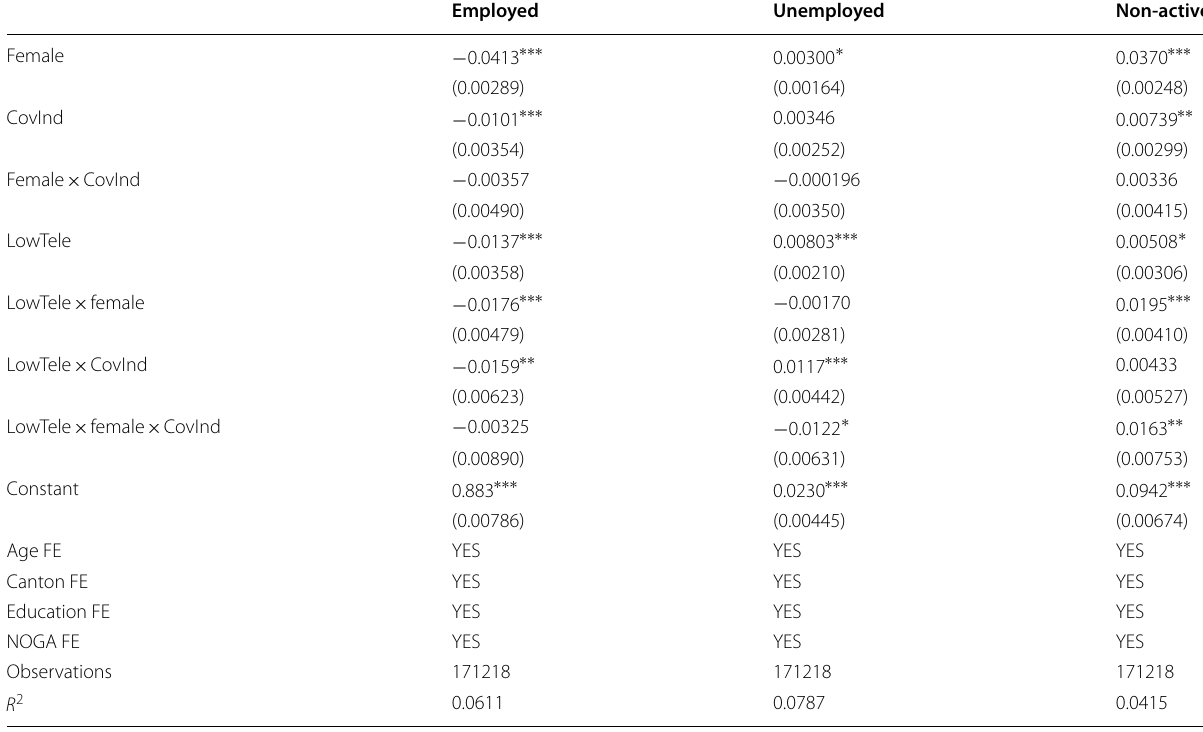
We show estimates from regression (2) of labor market status on a constant, female dummy (1 for women and 0 otherwise), COVID-19 stringency index, LowTele dummy (1 for respondents in an occupation with low telework availability and 0 otherwise), and their interactions. Regressions estimated with linear probability model, including random effects. Robust standard errors in parentheses. The sample is restricted to respondents who share complete information on occupation